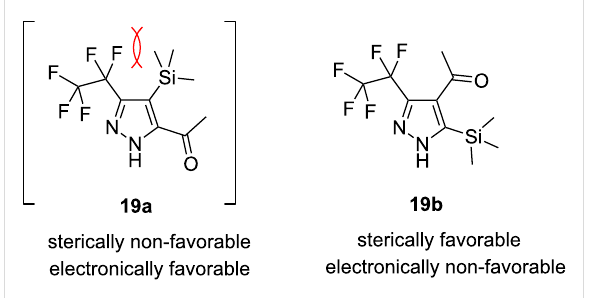
Figure 4: Structure of the expected product 19a , and the observed isomeric one – 19b .